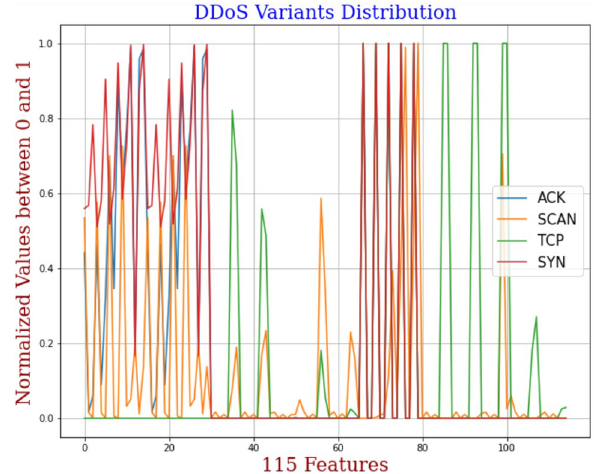
Figure 7. DDoS variants